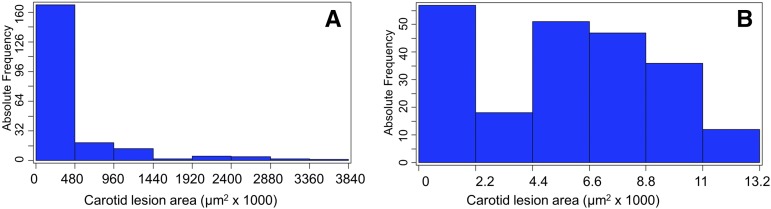
Frequency distributions of untransformed (A) and log2-transformed (B) total carotid lesion areas of 228 female F2 mice derived from BALB-Apoe−/− and SM-Apoe−/− mice. Each histogram indicates the number of individual F2 mice with a certain lesion area. Apoe−/−, apolipoprotein E-deficient.